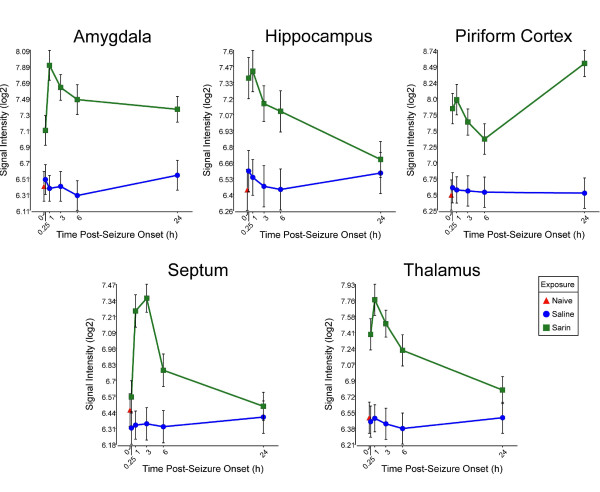
Sarin-induced seizure up-regulates the expression of IL-1β in all five brain regions examined. Tissues were collected at 0.25, 1, 3, 6, and 24 h after seizure onset and processed for oligonucleotide microarray analysis. IL-1β expression peaked at 1 h in the amygdala, hippocampus, and thalamus, while it peaked at 3 h in the septum and at 24 h in the piriform cortex. The expression levels decreased nearer to control level in the hippocampus, septum, and thalamus, while it remained approximately the same in the amygdala. However, IL-1β transcript level was increasing in the piriform cortex at our latest time point of 24 h.